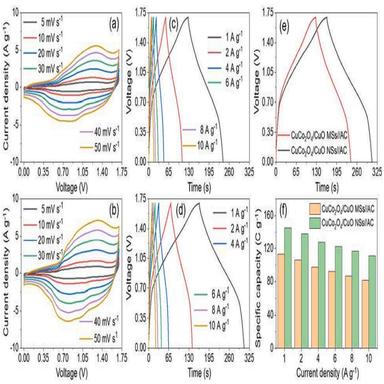
The electrochemical tests in two-electrode system: the CV curves of (a) CuCo2O4/CuO MSs//AC HSC and (b) CuCo2O4/CuO NSs//AC HSC at the scan rate from 5 to 50 mV s − 1 , the GCD profiles of (c) CuCo2O4/CuO MSs//AC HSC and (d) CuCo2O4/CuO NSs//AC HSC at the current density of 1–10 A g− 1 , (e) the GCD profiles of the both HSCs at 1 A g− 1 , and (f) the rate performance of the CuCo2O4/CuO MSs//AC and CuCo2O4/CuO NSs//AC HSCs.